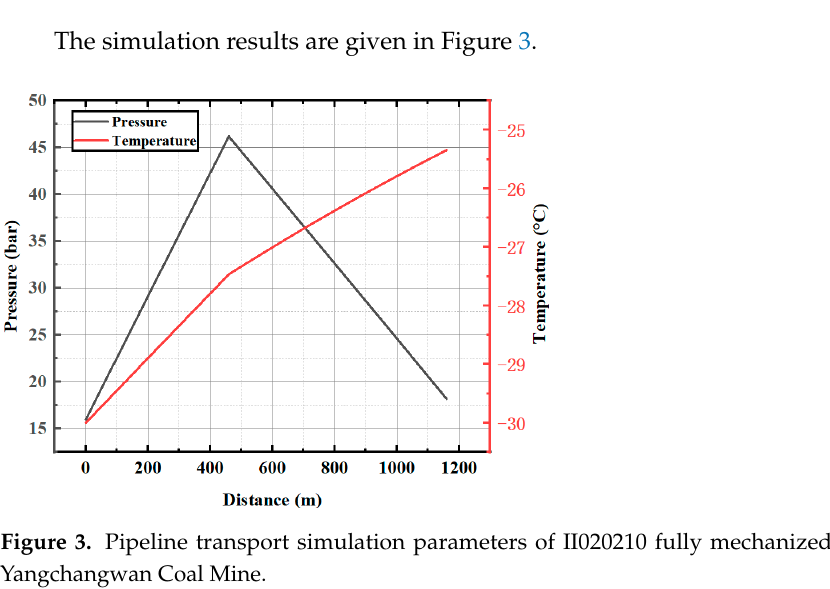
Table 1. Data of II020210 fully mechanized caving face in 2# coal seam of Yangchangwan Coal Mine. Parameters Actual Measured Values Inlet temperature − 30 ◦ C Inlet pressure In the range of 16 to 20 bar Outlet temperature Outlet pressure In the range of 15 to 20 bar